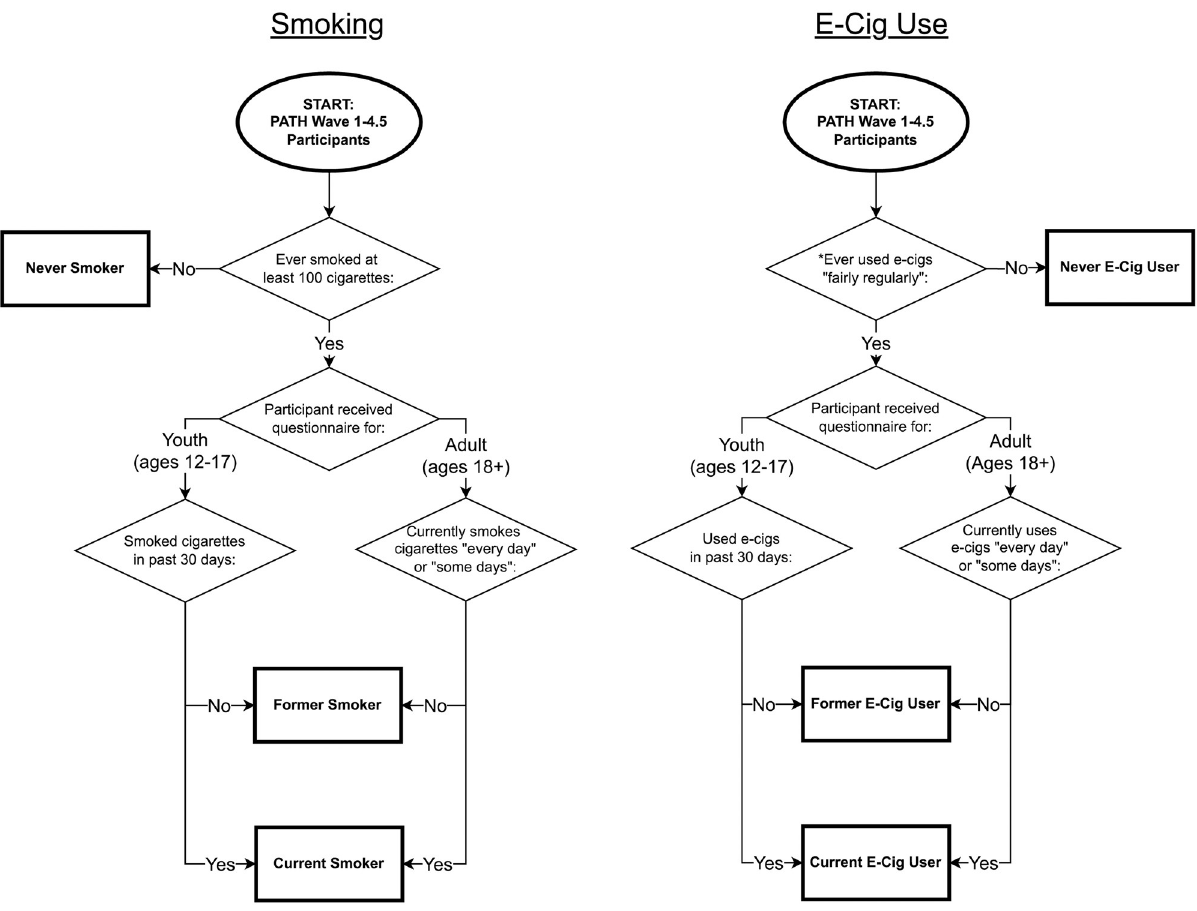
Fig 1. Classification of survey participants as never, former, and current smokers/e-cig users. Population Assessment of Tobacco and Health (PATH) Study Waves 1–4.5 respondents were classified into never, former, and current smoking/e-cig use. A single participant’s classification could differ between the two products: e.g., former smoker/current e-cig user. In youth survey Waves 1–2 and adult survey Wave 1, regarding electronic products, participants were asked only about “electronic-cigarettes.” In all other survey waves, participants were asked about e-product use, which included "e-cigarettes, vape pens, personal vaporizers and mods, e-cigars, e-pipes, e-hookah or hookah pens." For this analysis, we considered an affirmative response to either of these questions as indicative of e-cig use. * Youth in Wave 1 were asked to attest to ever use instead of ever “fairly regular” use of e-cigs. In our analysis, youth in Wave 1 who attested to never having used e-cigs were classified as never e-cig users. We classified all other youth as “undefined” for Wave 1 e-cig use and excluded them from the analysis in that